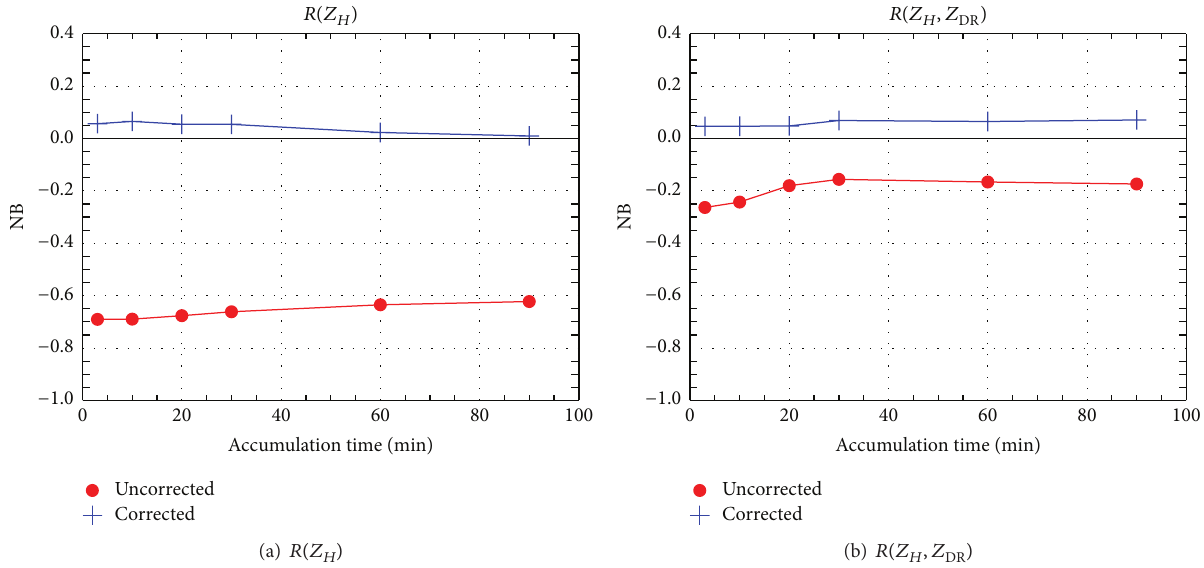
Figure 20: The normalized bias of 𝑅(6 km 2 ) versus 𝐺(6 km 2 ) with an accumulation time (a) using 𝑍 𝐻 and (b) using 𝑍 𝐻 and 𝑍 point-line and the blue point-line indicate without and with the attenuation correction, respectively.